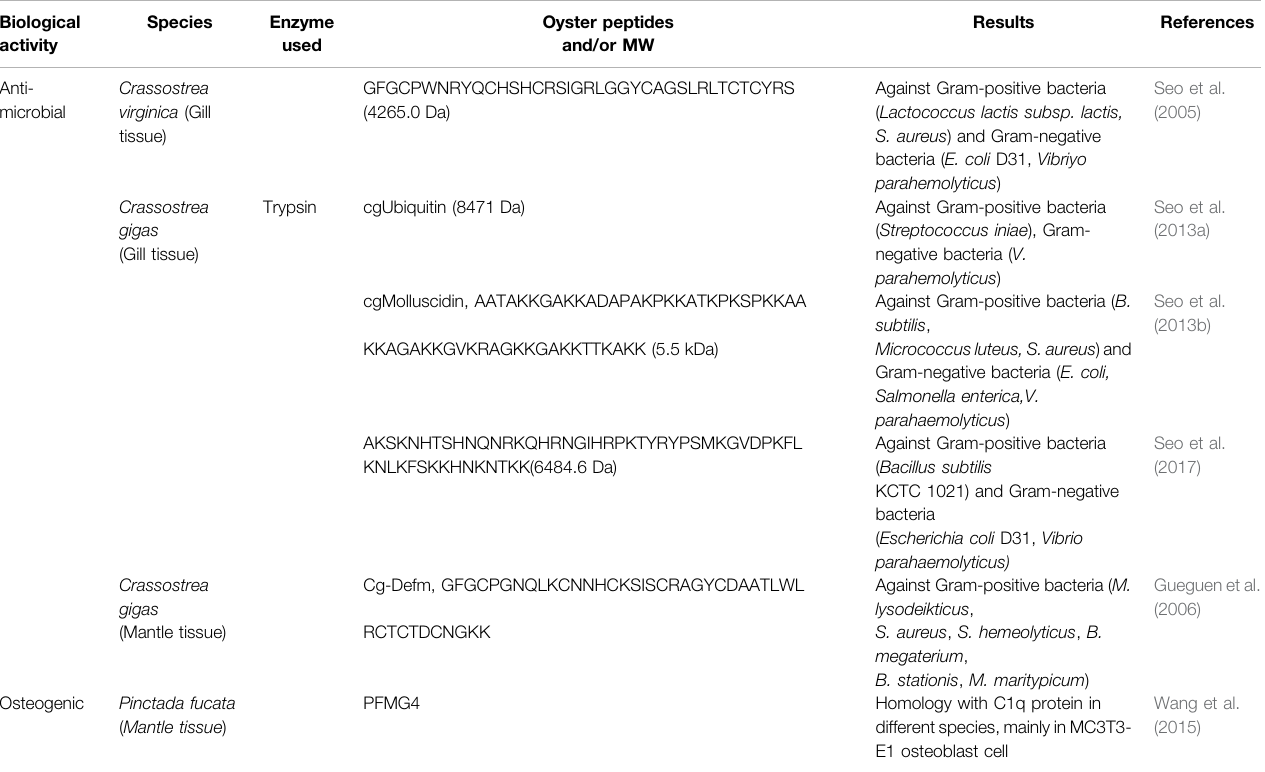
TABLE 5 | Bioactive peptides derived from oyster gill tissue and mantle